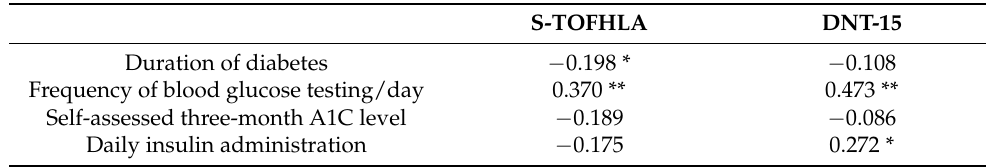
Table 3. The relationship between the S-TOFHLA and the DNT-15 scores, diabetes and health-related variables and Spearman’s rank correlation values. S-TOFHLA DNT-15 Duration of diabetes − 0.198 * − 0.108 Frequency of blood glucose testing/day 0.370 ** 0.473 ** Self-assessed three-month A1C level − 0.189 − 0.086 Daily insulin administration − 0.175 0.272